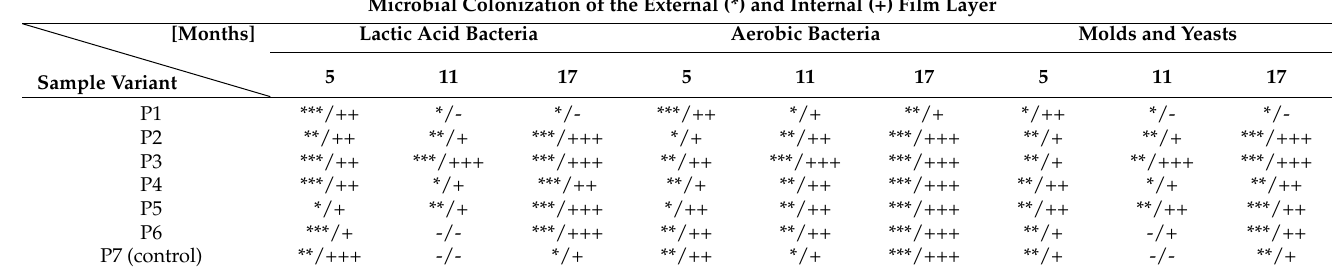
Table 1. The degree of microbial surface colonization of film variants after storage for 5, 11 and 17 months. Scale: -, no colonization; * or +, low colonization; ** or ++, medium colonization; *** or +++, intense colonization. An asterisk (*) symbol was used for the external and a plus (+) for the internal film